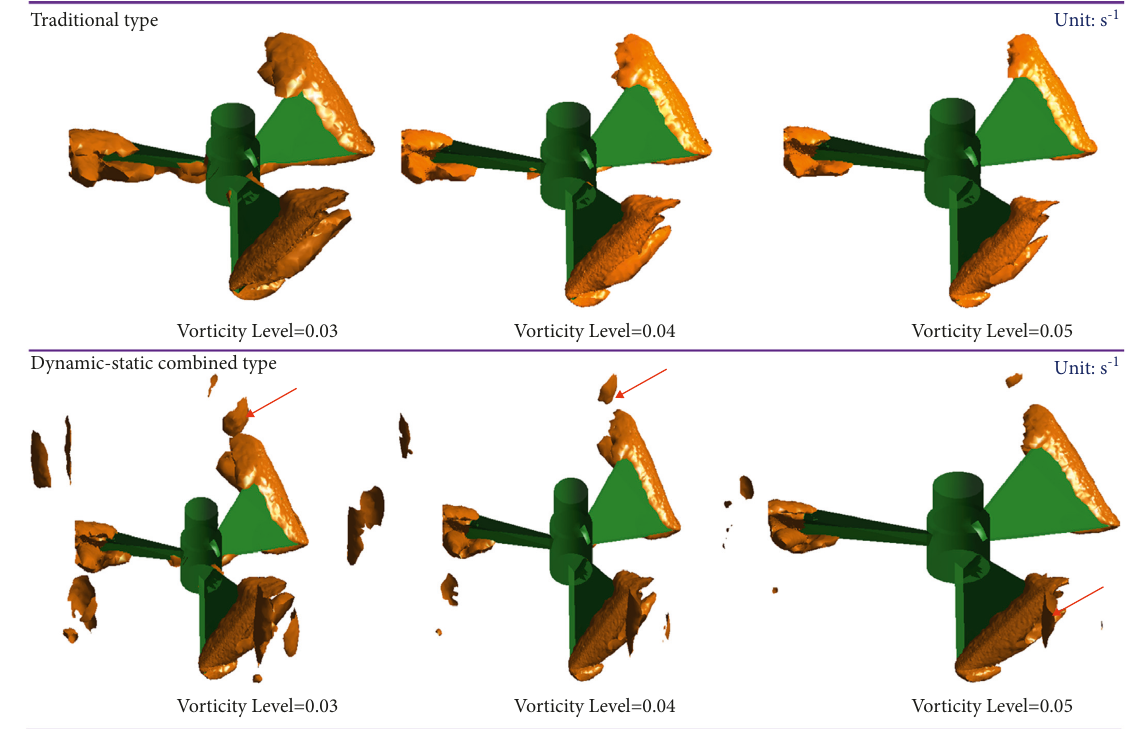
Figure 13: Cloud map of the trailing vortex distribution near the blades in the